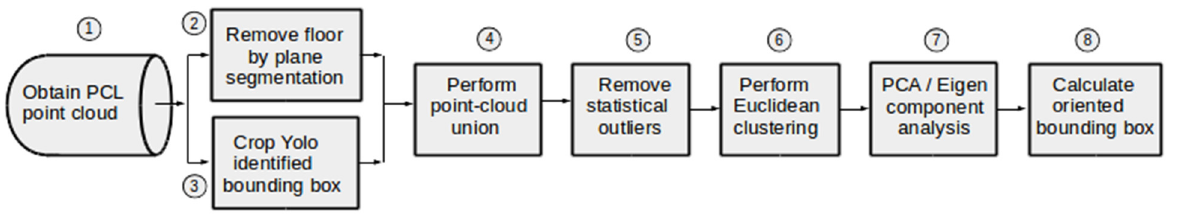
Figure 6. PCL pipeline for isolating and determining the location of a door.